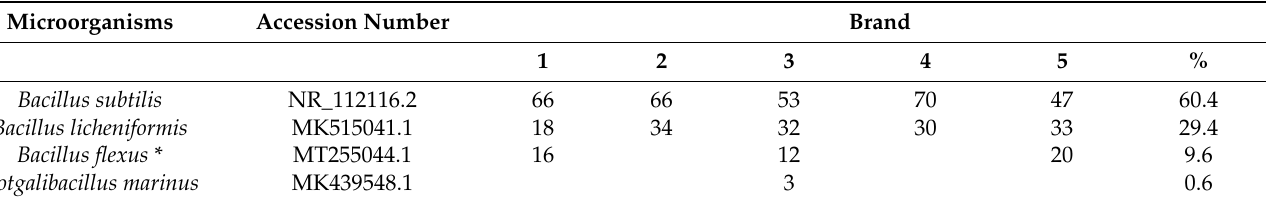
Table 1. Bacterial species isolated from chocolate.